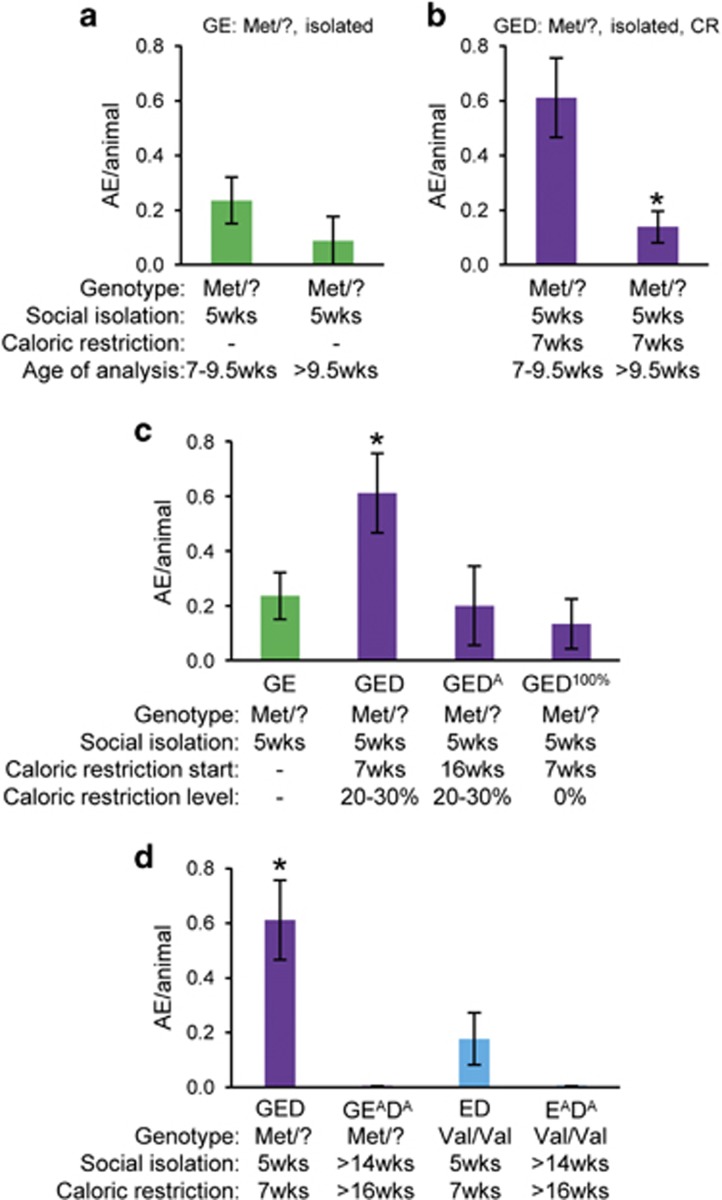
Impacts of caloric restriction and social isolation are conveyed in the peri-pubertal period. (a) Number of aphagic episodes (AE) per animal per group in singly housed hBDNFMet/? females (GE) from 7–9.5 weeks of age compared with those observed after 9.5 weeks (GE: 7–9.5, 0.23±0.08 AE per animal; >9.5, 0.09±0.09 AE per animal, n=34, 9 cohorts). P<0.05, Student's t-test. (b) Number of AEs per animal per group in singly housed hBDNFMet/? females under caloric restriction (CR) (GED) from 7–9.5 weeks of age compared with those observed after 9.5 weeks (GED: 7-9.5, 0.61±0.14 AE per animal; >9.5, 0.14±0.06 AE per animal, n=36, 6 cohorts). *P<0.05, Student's t-test. (c) Number of AEs per animal per group in GE, GED, singly housed hBDNFMet/? females exposed to CR during adulthood (GEDA) and singly housed hBDNFMet/? females fed 100% of their daily caloric intake twice daily at 7 weeks (GED100%) (GE, 0.23±0.08 AE per animal, n=34, 9 cohorts; GED, 0.61±0.14 AE per animal, n=36, 6 cohorts; GEDA, 0.20±0.14 AE per animal, n=15, 5 cohorts; GED100%, 0.13±0.09 AE per animal, n=15, 2 cohorts). *P<0.05, ANOVA. (d) Number of AEs per animal per group in GED, ED, hBDNFMet/? and hBDNFVal/Val females that were first exposed to single housing and CR during adulthood (GEADA, EADA (GED, 0.61±0.14 AE per animal, n=36, 6 cohorts; GEADA, 0 AE per animal, n=10, 2 cohorts; ED, 0.18±0.95 AE per animal, n=17, 6 cohorts; EADA, 0 AE per animal, n=10, 2 cohorts). *P<0.05, ANOVA. Error bars denote s.e.m. ANOVA, analysis of variance; GE, genetic susceptibility and environmental stressor.